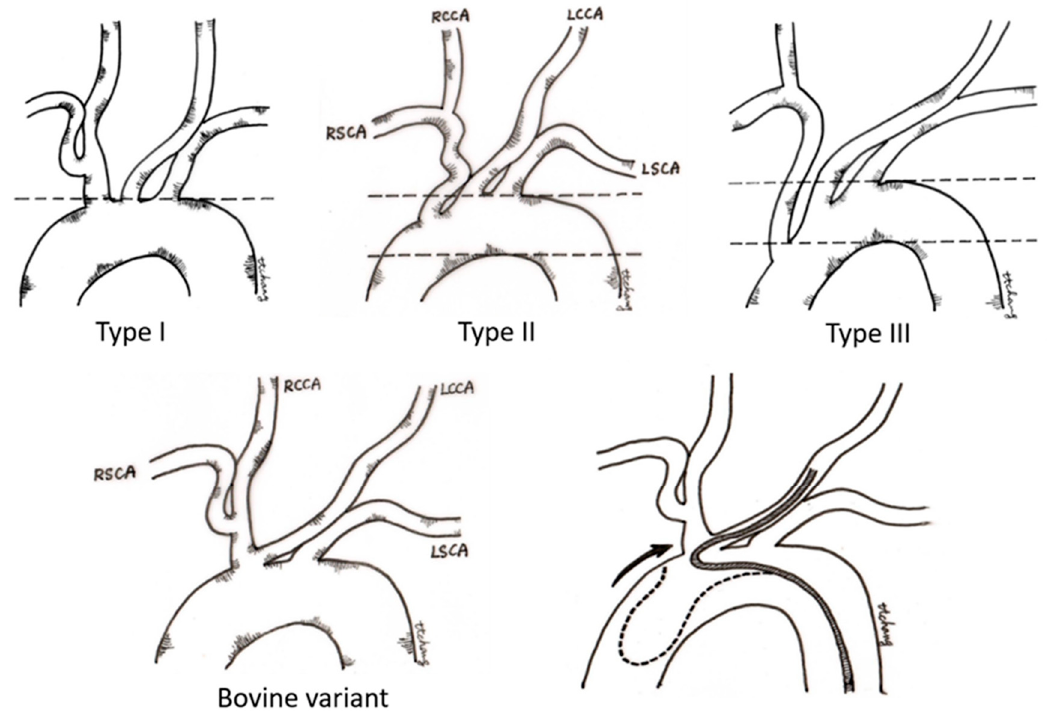
Figure 1. Classification of the aortic arch. In the type I aortic arch, the openings of all three major vessels are on the horizontal line of the upper curvature of the aortic arch. In the type II aortic arch, the innominate artery originates between the upper and lower curvature of the aortic arch. In the type III aortic arch, the origin of the innominate artery is below the horizontal line of the lower curvature of the aortic arch. For the type II and type III arch, access to the innominate trunk and left common carotid artery becomes increasingly difficult because a catheter approaching from the descending aorta tends to prolapse into the ascending aorta. In the bovine variant of aortic arch, the left common carotid artery originates from the innominate artery, and catheter navigation to the left common carotid artery usually requires special techniques of SIM2 catheter manipulation. (LCCA—left carotid artery; LSCA—left subclavian artery; RCCA—right common carotid artery; RSCA—right subclavian artery).